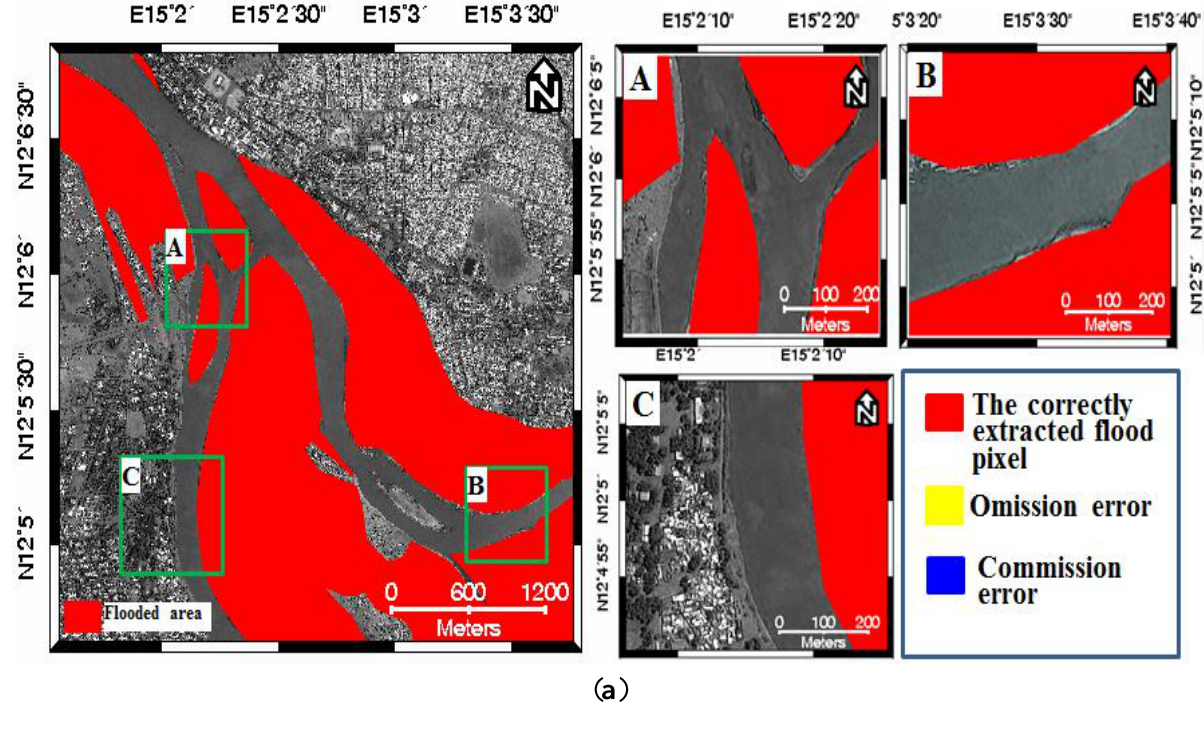
Figure 5. Result images of flooded area extraction using the tested methods: ( a ) Ground-truth image ( b ) MAD result; ( c ) CVA result; ( d ) SVM result; ( e ) MFI result; ( f ) result of the proposed method. The extracted flood pixels according to each method are represented in red